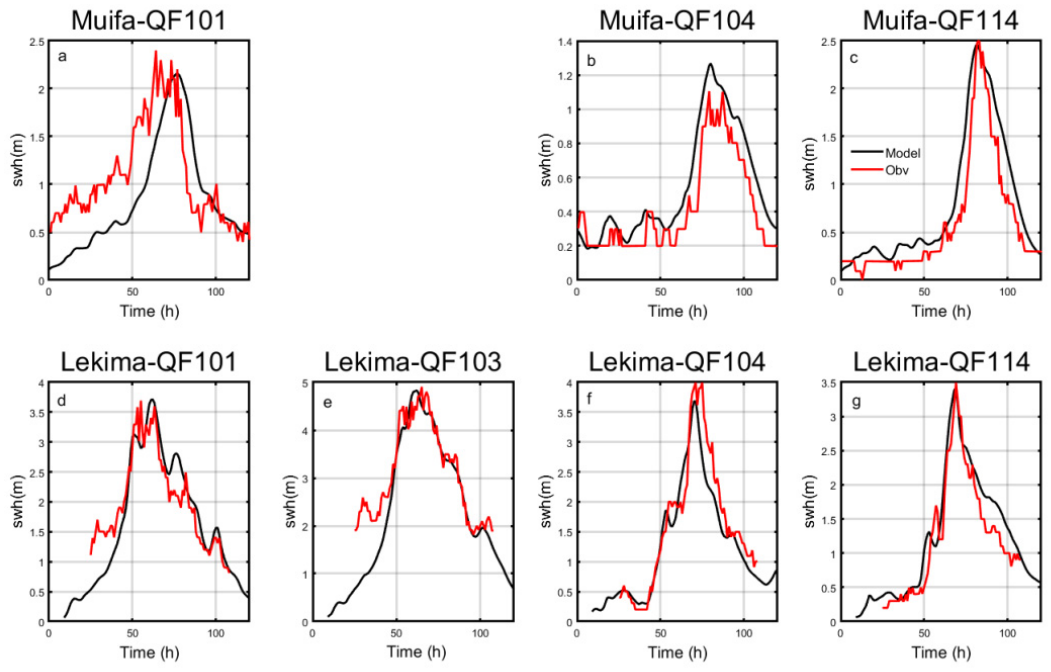
Figure 4. Reanalyzed ERA data and observations of the wind speed of Typhoon Muifa ( a – d ) and Typhoon Lekima ( e – h ) at buoys ( a , d ) QF101, ( b , f ) QF103, ( c , g ) QF104, and ( d , h ) QF114. The red line represents observations, and the black line represents reanalyzed data from ERA5.